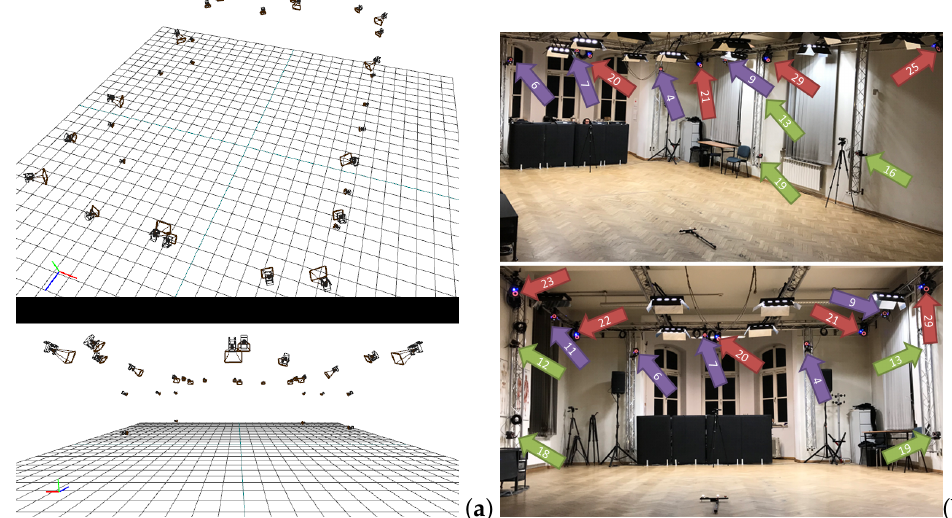
Figure 4. Camera locations: ( a ) Schematic view in Vicon Blade software, ( b ) actual setup in HML. Color denotes camera series: violet—Vantage, green—Bonita, red—T40.